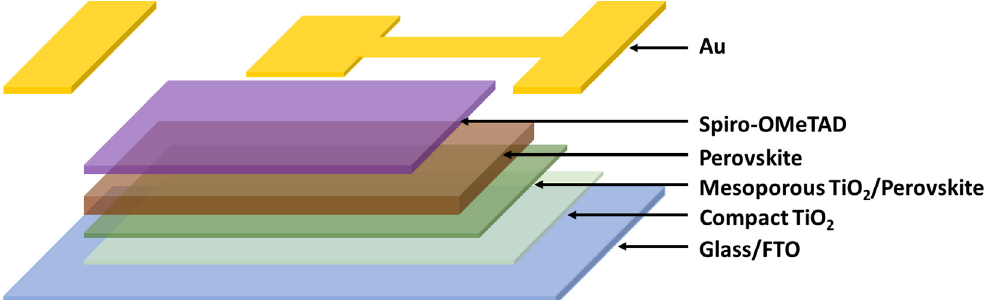
Figure 1. Exploded schematic view of the perovskite solar cell structure.